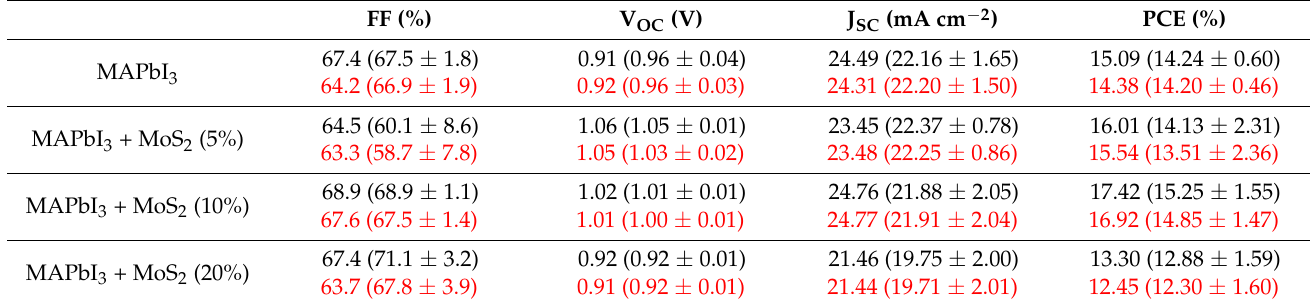
Figure 8. J-V curves of the MAPbI 3 best-performing PSC: ( a ) MAPbI 3 ; ( b ) MAPbI 3 + MoS 2 (5%); ( c ) MAPbI 3 + MoS 2 (10%); ( d ) MAPbI 3 + MoS 2 (20%). Table 4. Photovoltaic characteristics of the MAPbI 3 best-performing PSC and average values as well as standard deviations: reverse scan (black), forward scan (red).